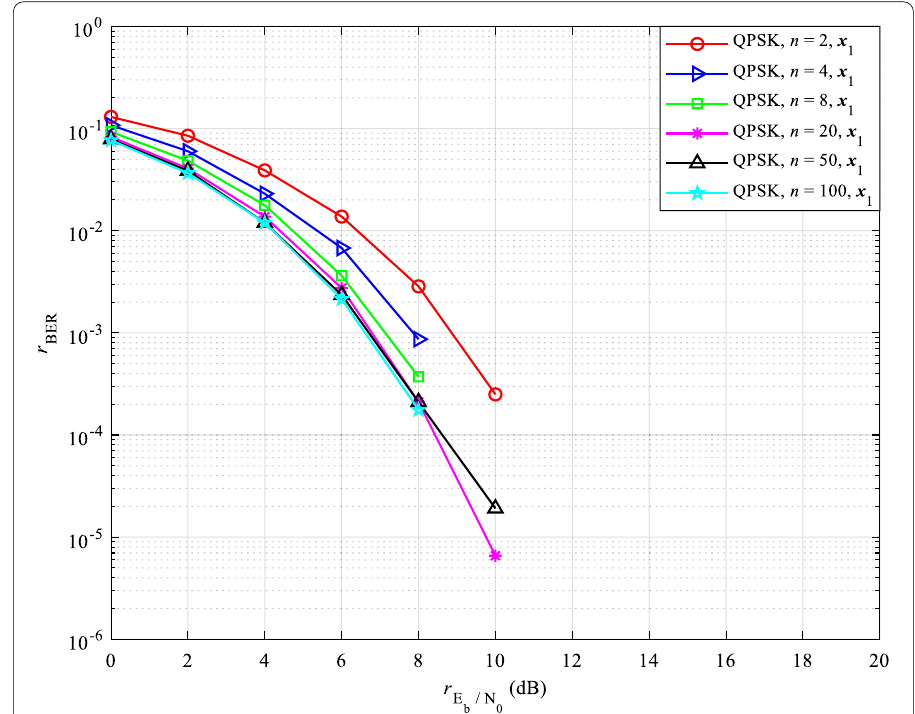
Fig. 5 BER performance of QPSK modulated 2 x 1 insertion